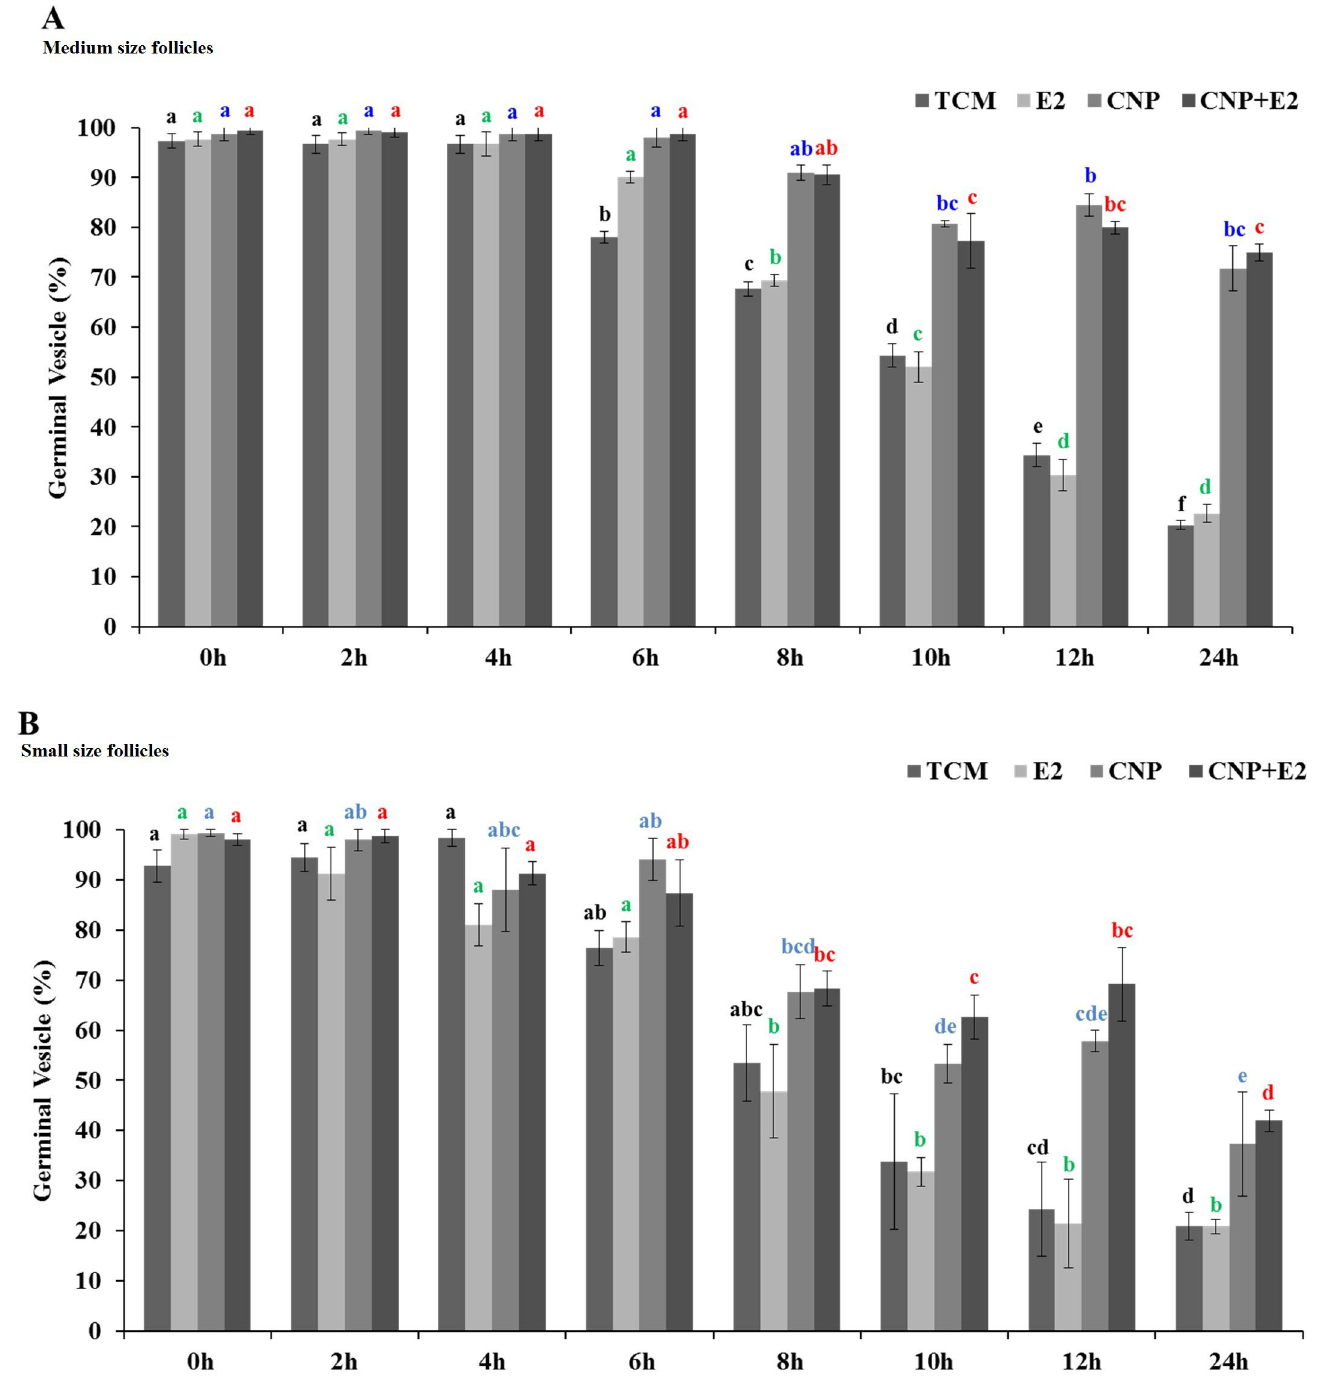
Fig 5. Percentage of oocytes at the GV stage during 24 h IVM in four experimental groups (TCM, E2, CNP, CNP+E2). A : medium size follicles ( > 4 to 6 mm) B : small size follicles (2 to � 4 mm). 3 replicates and the minimum number of oocytes in each replicate were 20. Different superscripts demonstrate significant differences (P < 0.05) within columns with the same color. TCM: tissue culture medium, E2: estradiol, CNP: natriuretic peptide type C.